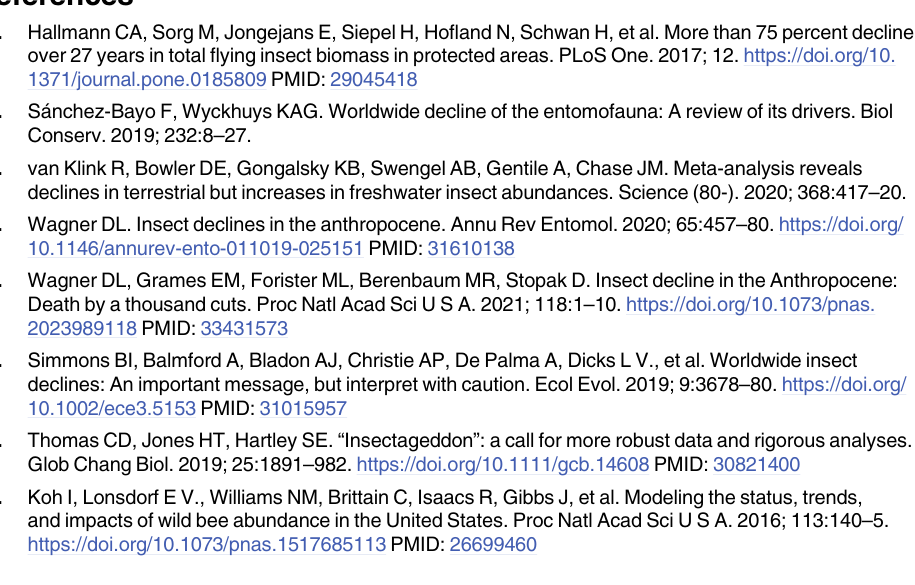
S1 Fig. PRISMA flow